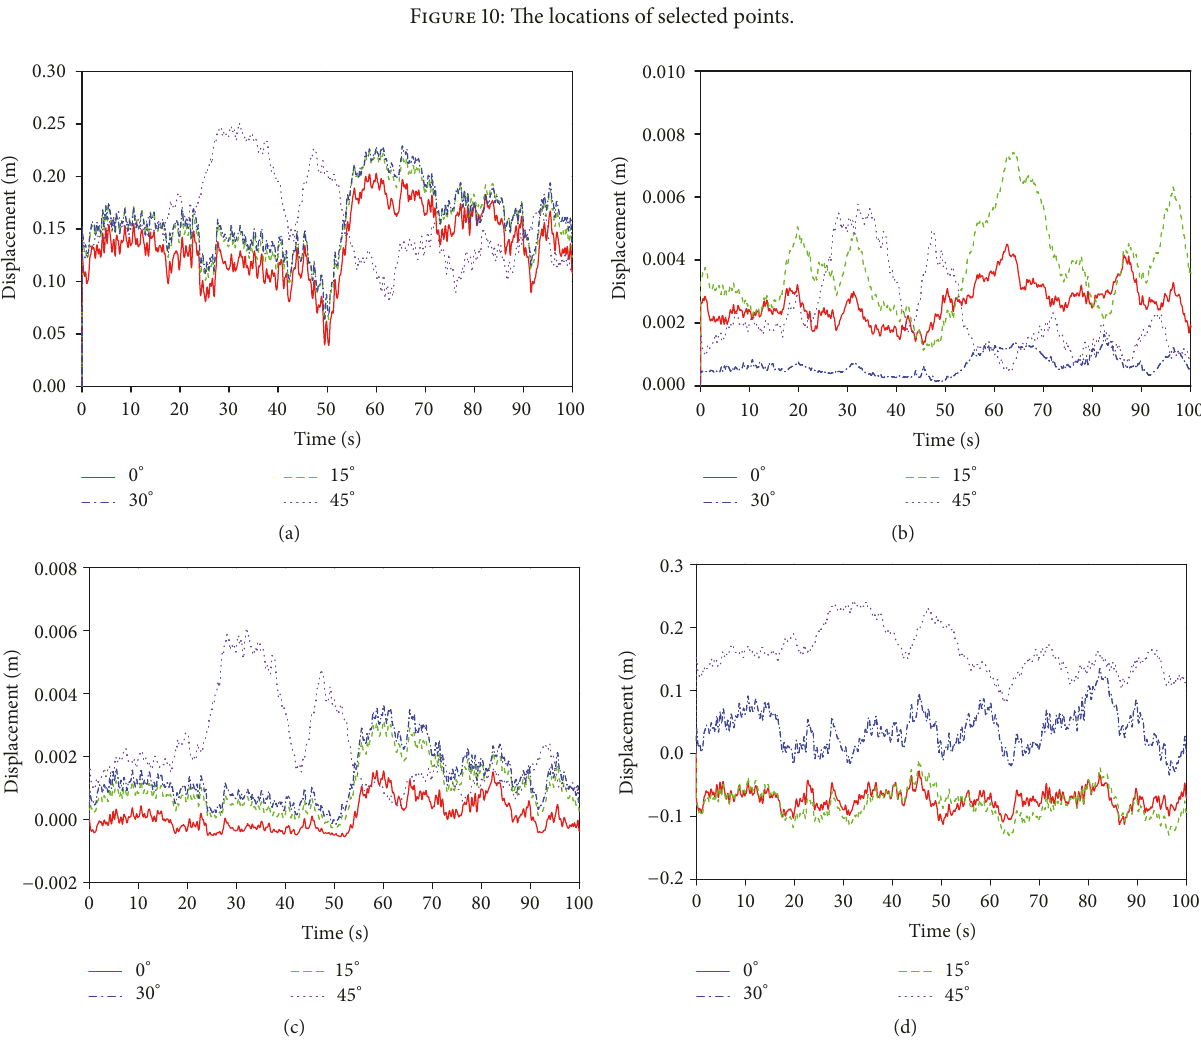
Figure11:Displacementresults:(a) 𝑋 displacementofpoint1;(b) 𝑋 displacementofpoint2;(c) 𝑌 displacementofpoint2;(d) 𝑌 displacement of point